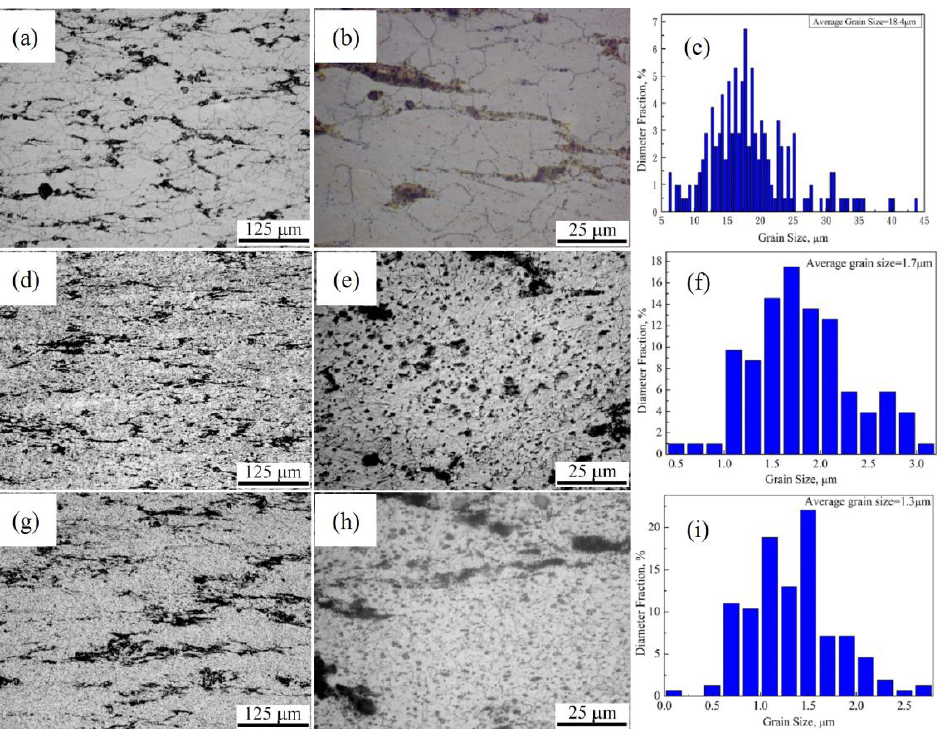
Figure 6. OM images and grain size distribution of nano-SiCp/AZ91 composite after multi-pass forging with varying temperatures: ( a – c ) 6 passes at 400 °C; ( d – f ) 6 passes at 400 °C and 3 passes at 350 °C; ( g – i ) 6 passes at 400 °C, 3 passes at 350 °C and 3 passes at 300 °C.